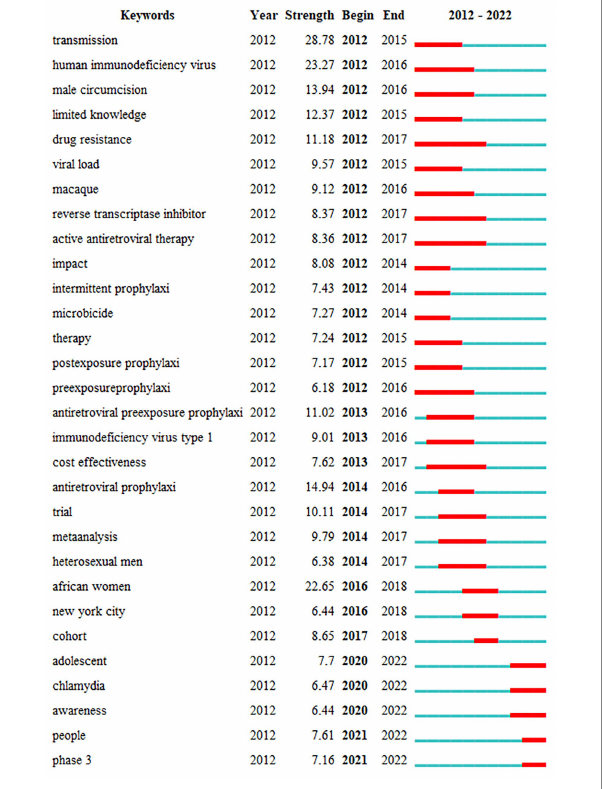
FIGURE 10 The top 30 references with the strongest citation